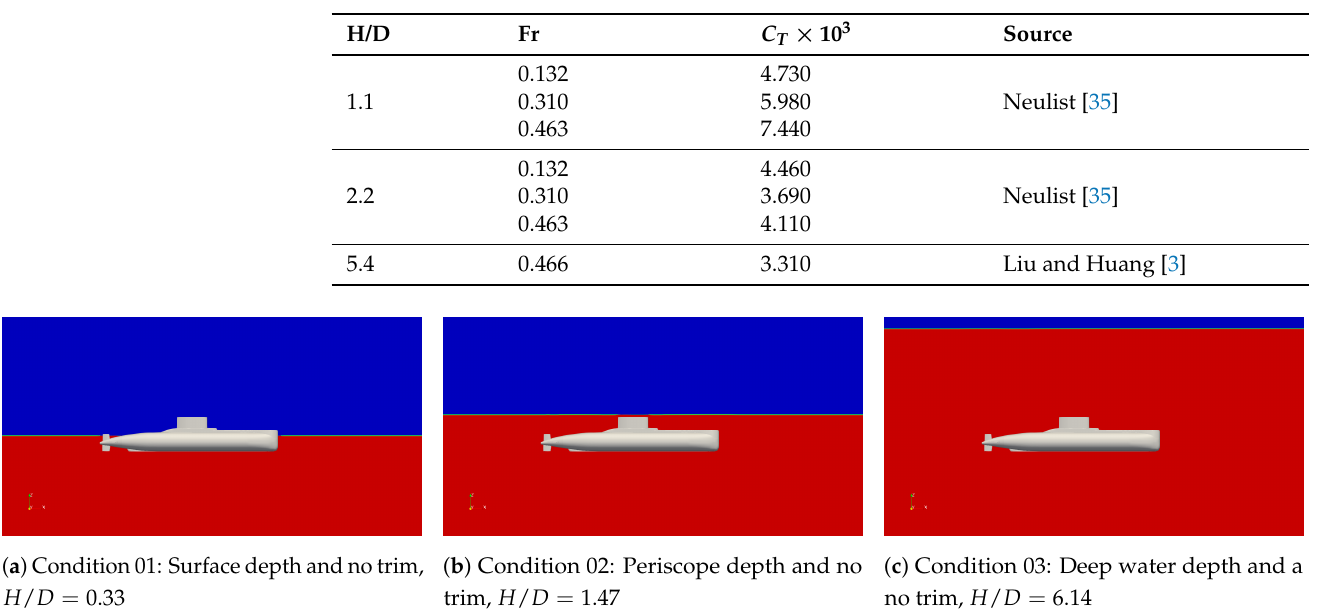
Table 5. Experimental data used for Verification and Validation of DARPA–SUBOFF subma- rine simulations.